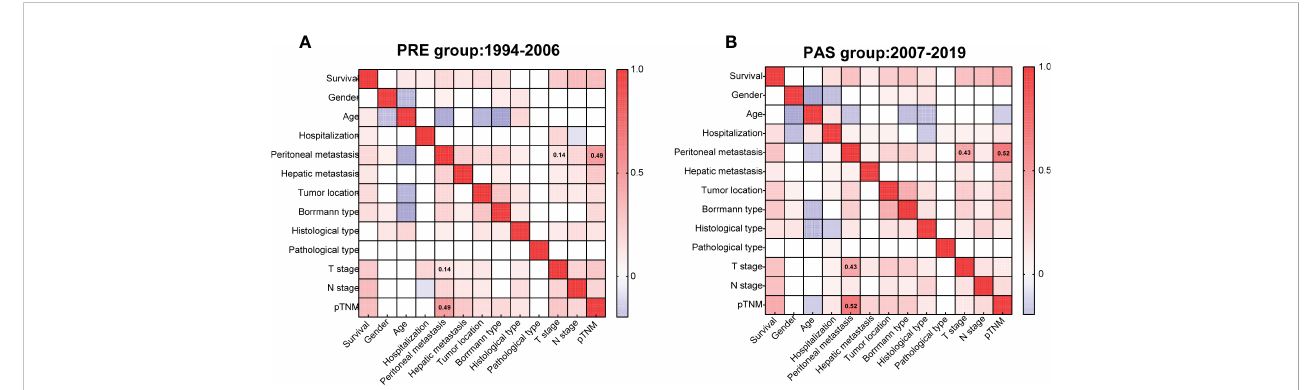
FIGURE 4 Heat maps showing the correlations of the gastric cancer patients ’ clinicopathologic indices of the PRE group (A) and the PAS group (B) . Kendall ’ s tau-b was used for the correlation analysis.